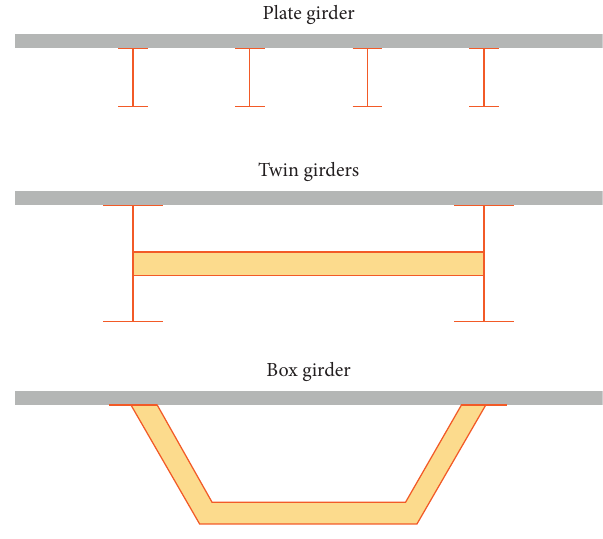
Figure 2: Bridge cross sections considered.